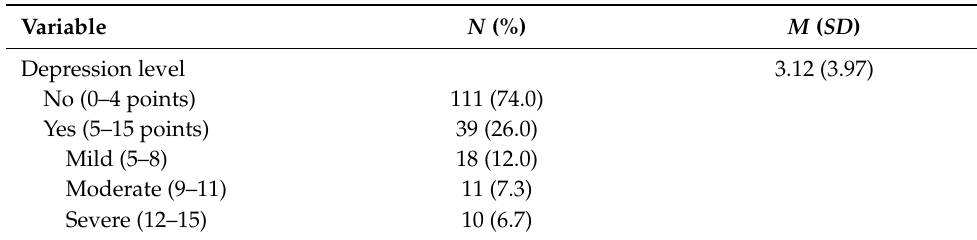
Table 2. Depression level of community-dwelling elderly persons ( N = 150).